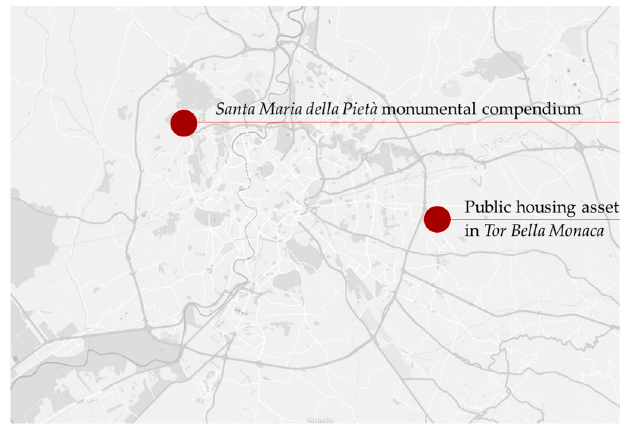
Figure 3. Localization of the two urban transformation areas considered in the analysis within the city of